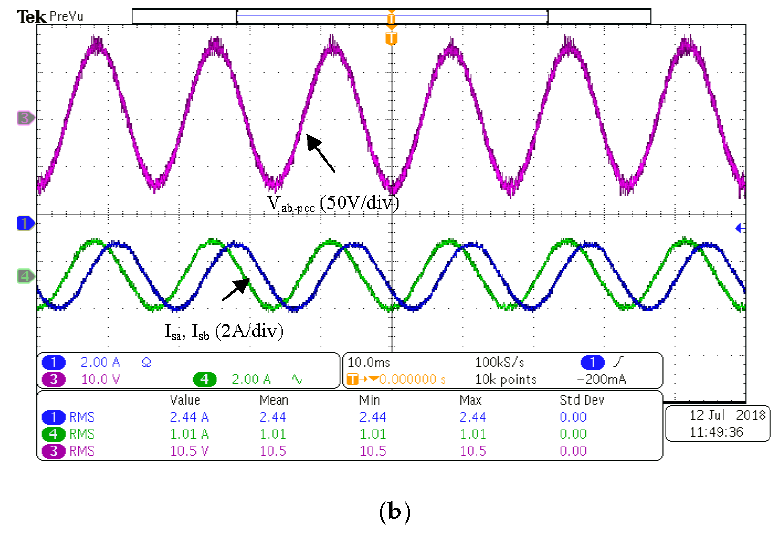
Figure 10. ( a ) v ab-pcc , i sa and i sb without the shunt APF. ( b ) v ab-pcc , i sa and i sb with the shunt APF. (10 ms/div).